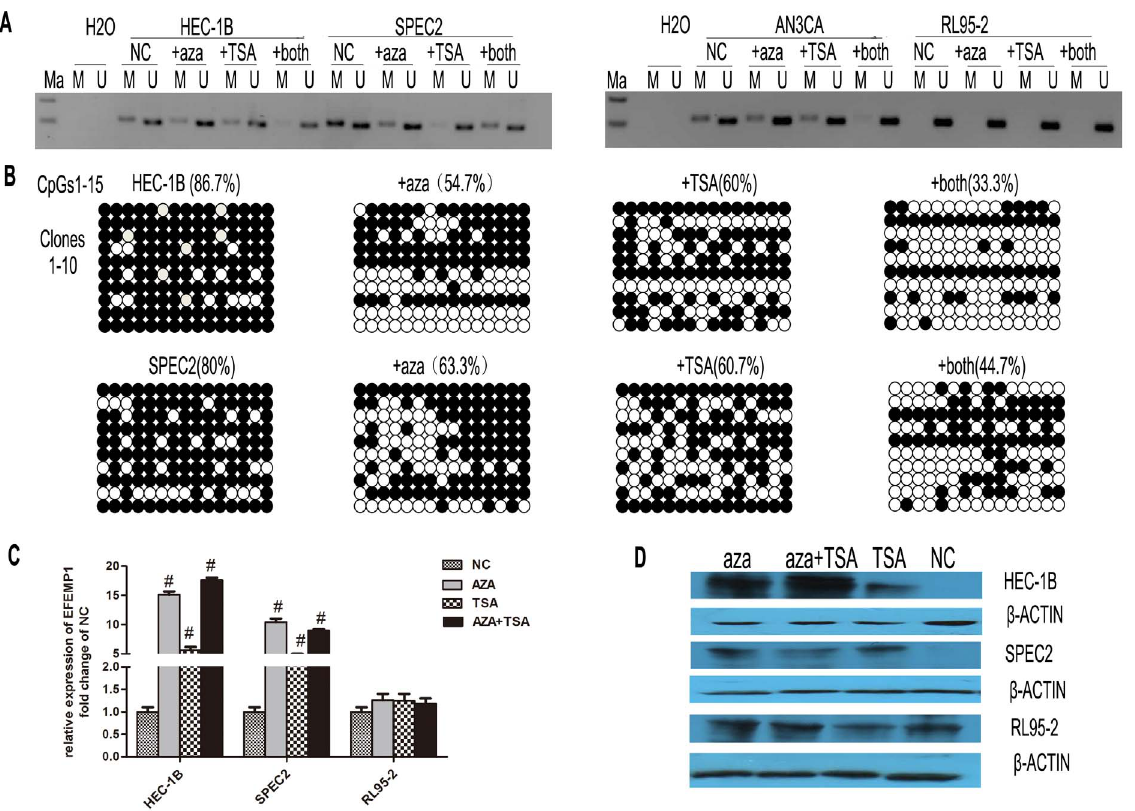
Figure 3. The effect of 5-aza-dC and TSA on EFEMP1 expression. A: Endometrial carcinoma cell-lines HEC-1B, AN3CA and SPEC2, shown to be methylated in the DNA promoter regain of EFEMP1, and RL95-2 shown to be unmethylated. Cells were treated with 5-aza-dC (10 m M) and/or TSA (200 ng/ml) for 96 h, and the methylation status of EFEMP1 was assessed by MSP. B: Bisulfite genomic sequencing detected endogenous levels of methylation before and after treatment with 5-aza-dC (10 m M) and/or TSA (200 ng/ml). Columns indicate clones 1–10; horizontal lines show the analysis of CpG dinucleotides 1–15. Black dots symbolize methylated CpGs, and white dots symbolize unmethylated CpGs. C: Showing qRT-PCR analysis and evaluation of EFEMP1 mRNA expression before and after treatment with 5-aza-dC and/or TSA. Data representative of three independent experiments are shown. # P , 0.05. D: Western immunoblot showing changes in EFEMP1 protein expression. Protein samples were extracted from cells that were treated with 5-aza-dC and/or